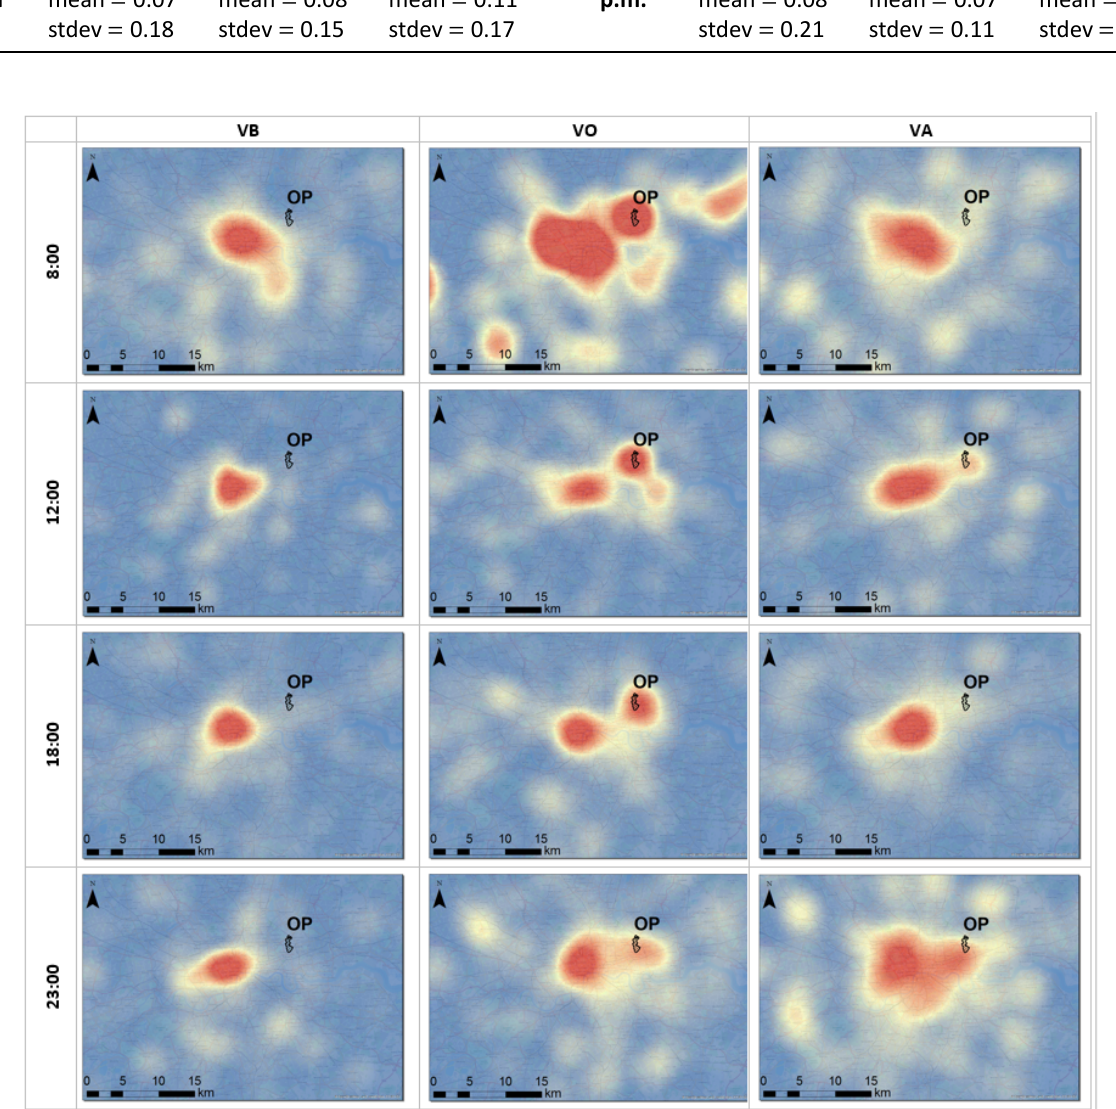
Figure 2. Hot spots of visitors’ negative tweets for specific